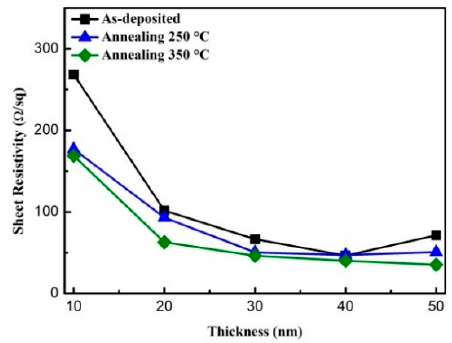
Figure 6. The sheet resistance of CoFeW films.